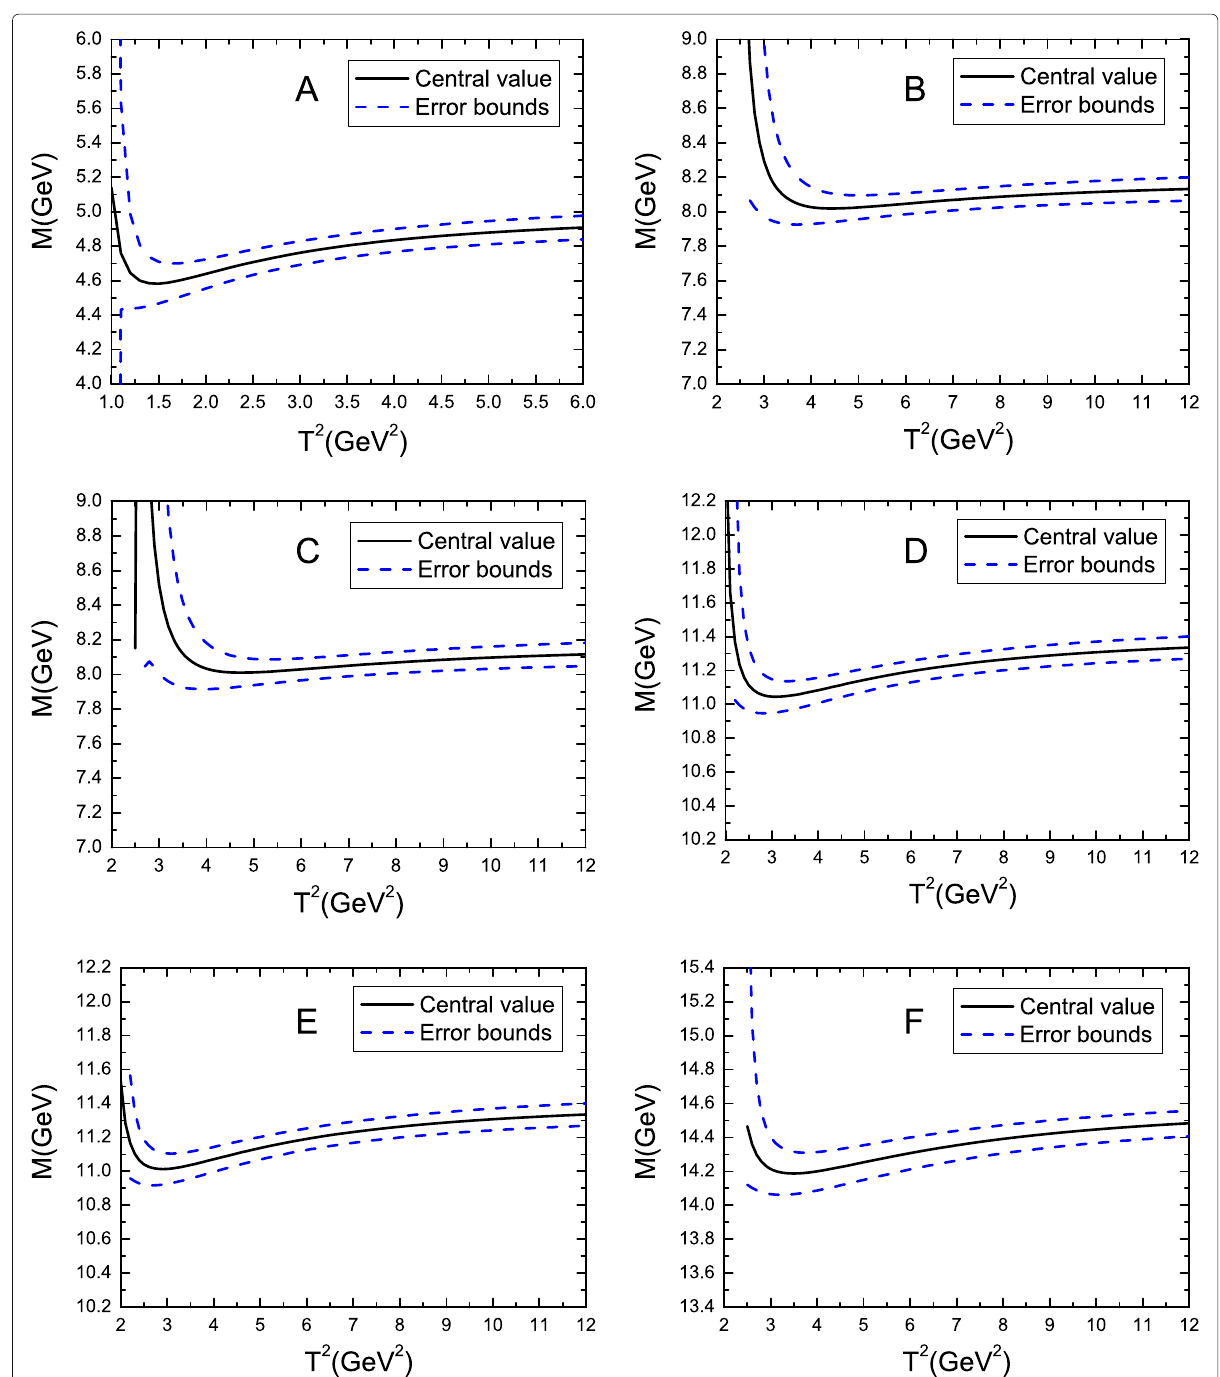
Fig. 2 The masses of the triply heavy baryon states with variations of the Borel parameters T 2 , where A , B , C , D , E , and F denote the baryon states + ) + + + + , ccb 1 , bbc 3 , bbc 1 , and bbb 3 , ccb 3 ccc ( 3 2 2 2 2 2